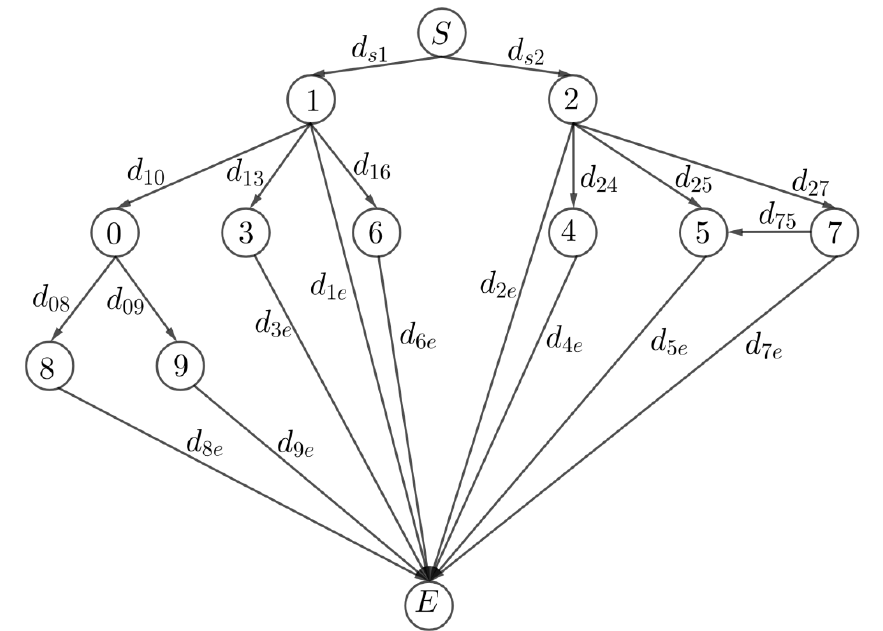
Figure 3. Digraph G 1 — the current procedure in the presented example. G — the current procedure in the presented example. Figure 3. Digraph 1 G is equal to The weight of 1